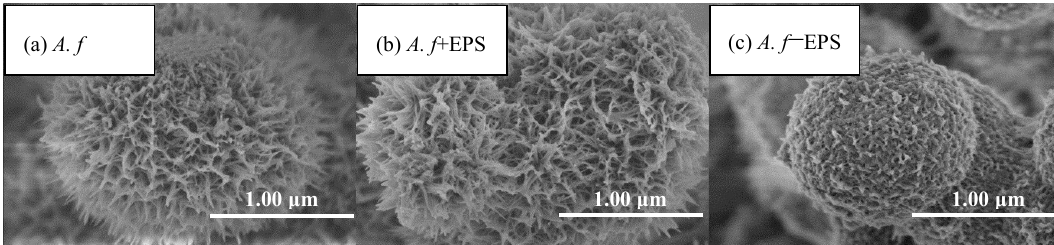
Figure 6. SEM images of biosynthesized schwertmannite under different treatment at 28 °C and 180 rpm for 72 h: ( a ) A. f : conventional A. ferrooxidans ; ( b ) A. f +EPS: A. ferrooxidans with EPS exfoliated but not removed; ( c ) A. f −EPS: A. ferrooxidans with EPS exfoliated and removed. Experimental conditions: initial pH = 3.0; FeSO 4 ·7H 2 O dosage 11.12 g; A. ferrooxidans density 6.0 × 10 6 cell·mL −1 .